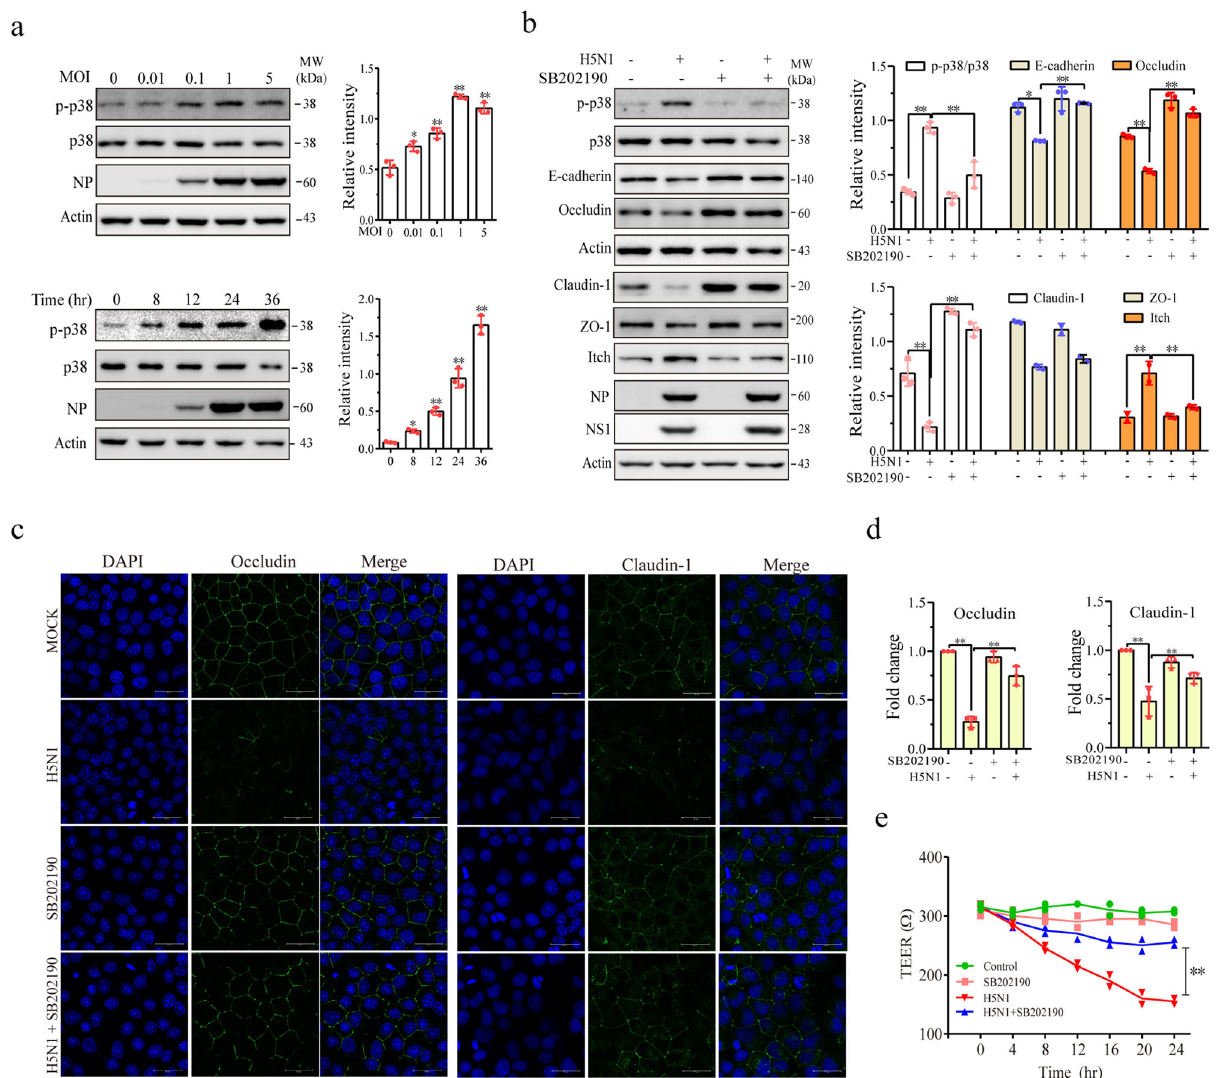
Fig. 4 Role of p38 in H5N1 virus-induced Itch expression and degradation of junction proteins. a H5N1 viruses induce p38 phosphorylation. A549 cells were infected with the indicated MOI of H5N1 viruses for 24 h or infected with 1 MOI of H5N1 viruses for the indicated lengths of time. Cell lysates were analyzed for the levels of p38 phosphorylation, NP, and β -actin by Western blot. b SB202190 blocks H5N1 virus-induced Itch expression and junction protein downregulation. A549 cells were left uninfected or infected with the H5N1 virus (1 MOI). After incubation for 12 hr, SB202190 (10 μ M) was added and incubated for another 12 h. Cell lysates were prepared and analyzed for the levels of p38 phosphorylation, Itch, and junction proteins by Western blot with the indicated antibodies. The density of bands was analyzed using NIH Image-J software and normalized by the arbitrary units of total p38 or β -actin. Data represent the mean ± SD of three experiments. *p < 0.05, **p < 0.01. c SB202190 blocks H5N1 virus-induced disruption of intercellular junction structure. A549 cells were left uninfected or infected with H5N1 viruses (1 MOI). The cells were then incubated in the absence or presence of SB202190 (10 μ M) for 24 h. The cells were fi xed and stained with the antibodies against occludin or claudin-1. d Quanti fi cation of fl uorescence signals. The monolayers immunostained for occludin and claudin-1 were analyzed for immuno fl uorescence intensity by using Image J software. The fl uorescent signals of intercellular junctions were quanti fi ed and plotted as bar graphs. Data represent the mean ± SD of fi ve random fi elds (40X) from one of three independent experiments with similar results. e SB202190 prevents the H5N1 virus-induced decrease of electronic resistance. A549 cells seeded in the Transwell inserts were left uninfected or infected with H5N1 viruses in the absence or presence of SB202190 (10 μ M). TEER was measured at the indicated times. The results represent the mean ± SD of three independent experiments. * p < 0.05, ** p <